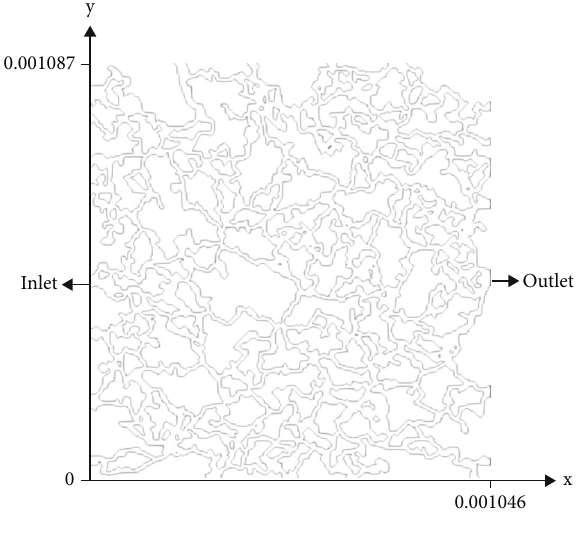
Figure 2: Physical